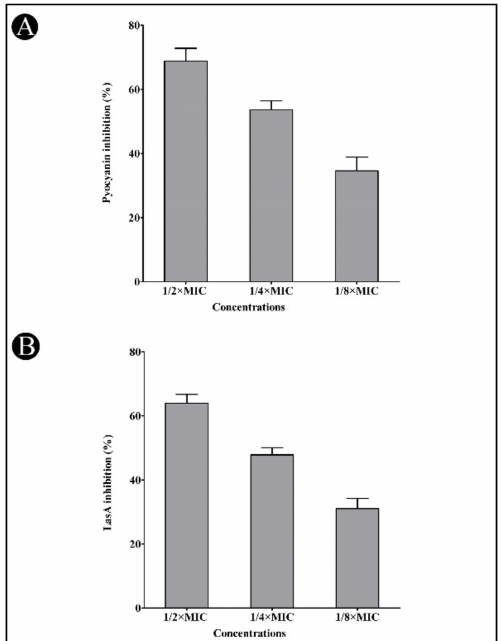
Figure 6. Inhibition of pyocyanin ( A ) and LasA ( B ) by synthesized AgNPs in P. aeruginosa at the sub-MIC concentrations (1/2, 1/4 and 1/8 MIC). Values are presented as mean ± SD of three independent